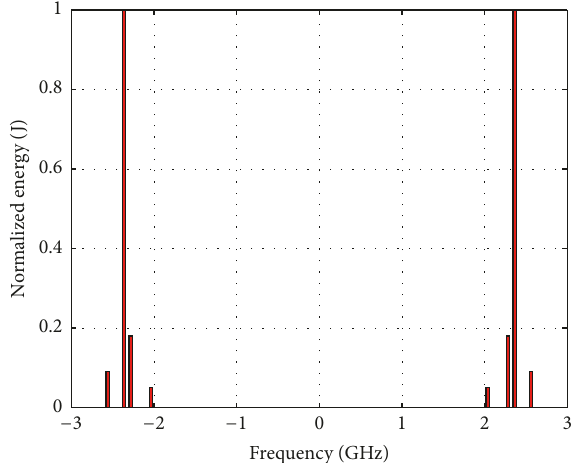
Figure 20: Pole normalized 𝐸 levels with